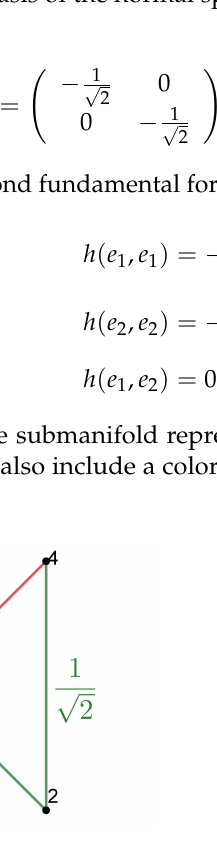
Figure 8. Clifford torus representation as a submanifold of R 4 .